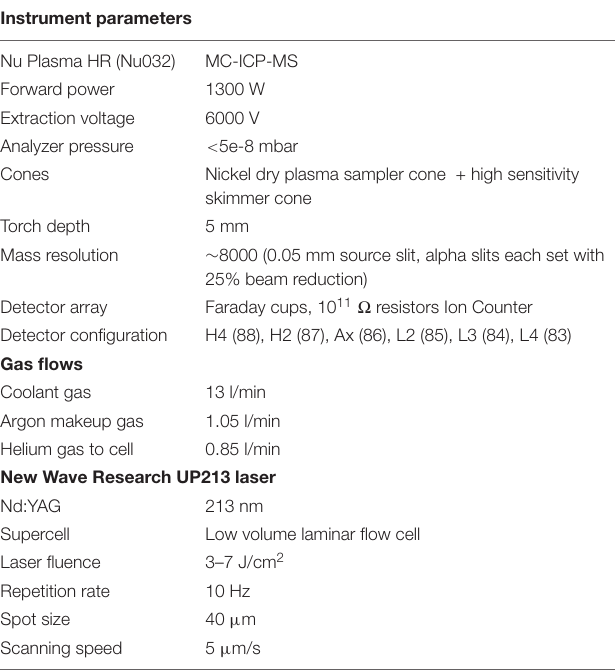
TABLE 2 | Instrument operating conditions of the Nu Plasma HR (Nu032) and New Wave Research UP213 Nd:YAG 213 nm laser. Instrument parameters